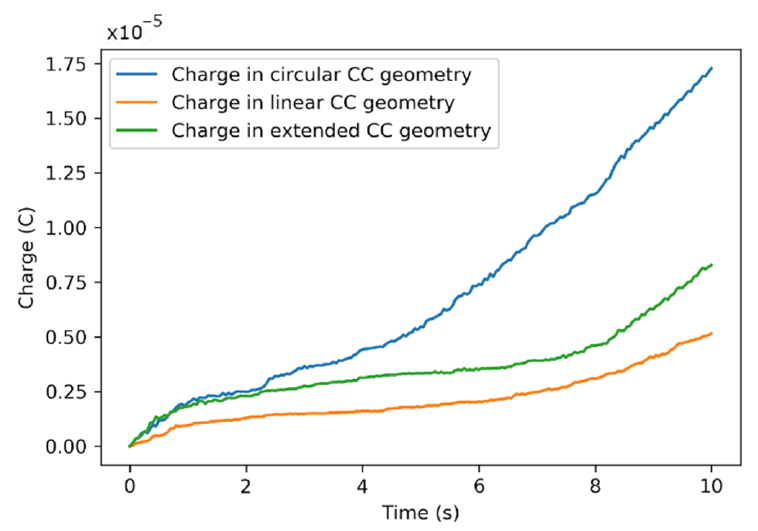
Figure 11. Total charge in three geometrical designs with optimized values of modeling parameters at the constant voltage of 0.75 V.